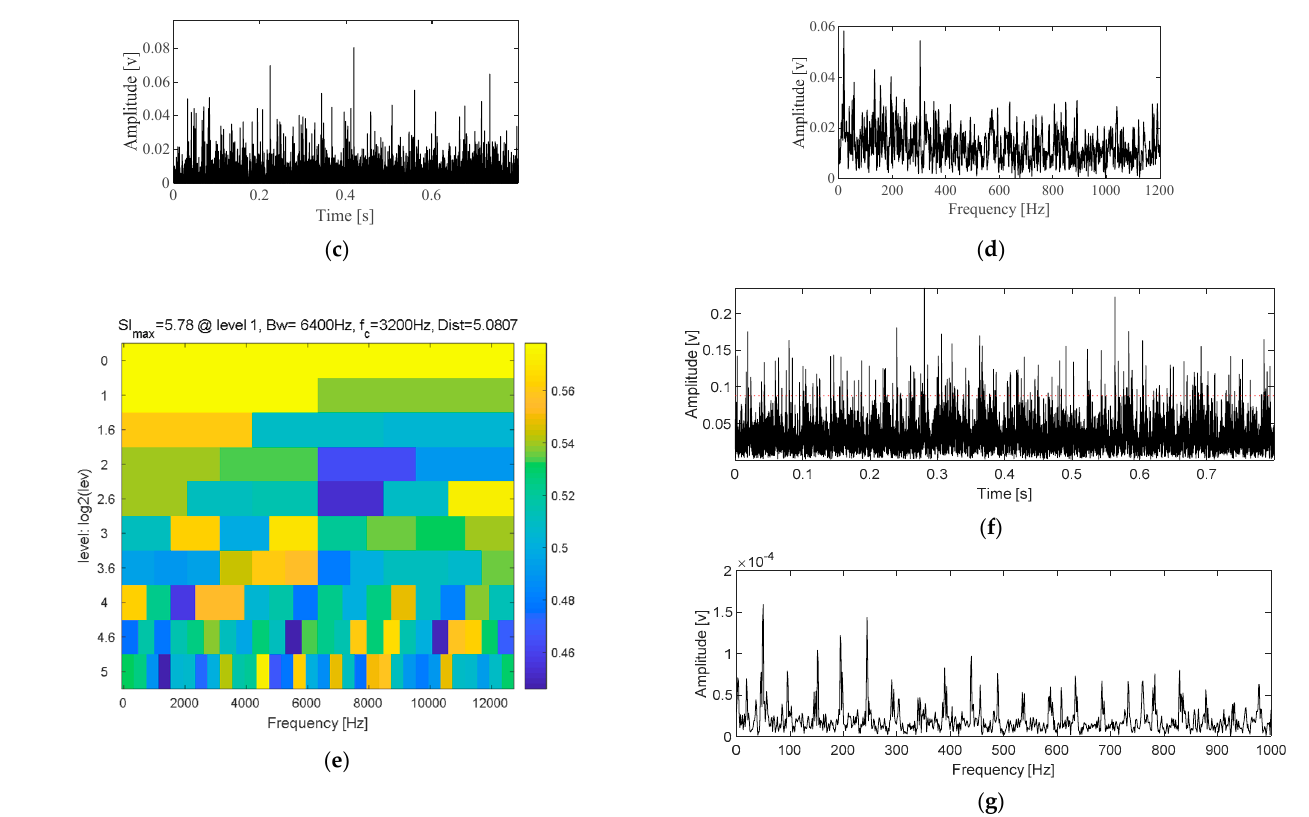
Figure 7. Experiment verification of the proposed method. ( a ) The original vibration signal of the experimental bearing at its early weak fault stage. ( b ) Envelope spectral of the signal shown in ( a ). ( c ) The filtered signal of the signal shown in ( a ) using AMF. ( d ) Envelope spectral of the signal shown in ( c ). ( e ) Analysis result of the signal shown in ( c ) using the proposed FBS method. ( f ) Envelope of the filtered signal of the signal shown in ( c ) using the proposed FBS method. ( g ) FFT of the signal shown in ( f ).